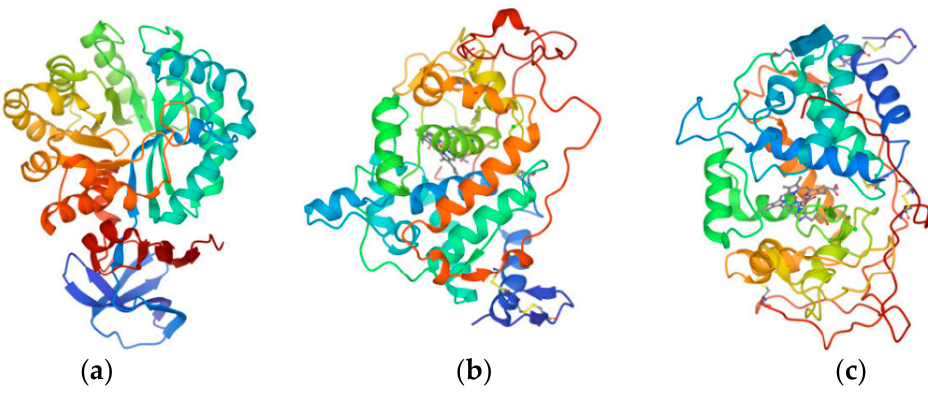
Figure 5. Schematic diagram of the structure of a universal degrading protein of S-TH substitutes in the soil environment: ( a ) 2QT3; ( b ) 1B85; ( c ) 1MNP.